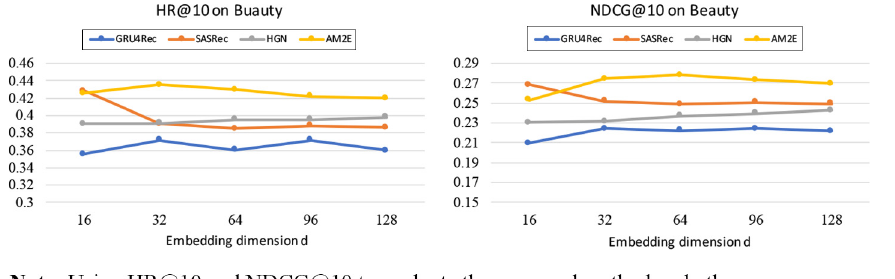
Figure 4. In fl uence